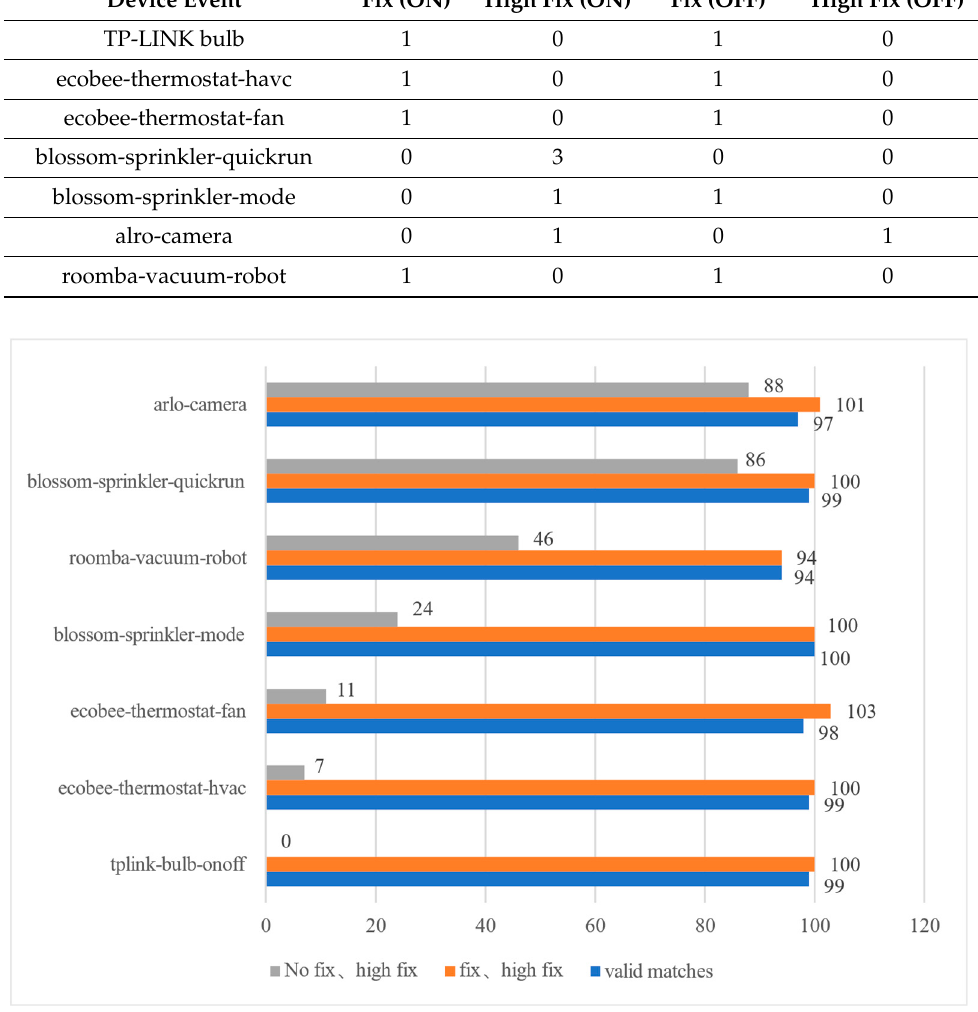
Figure 12. Fix parameter experiment.